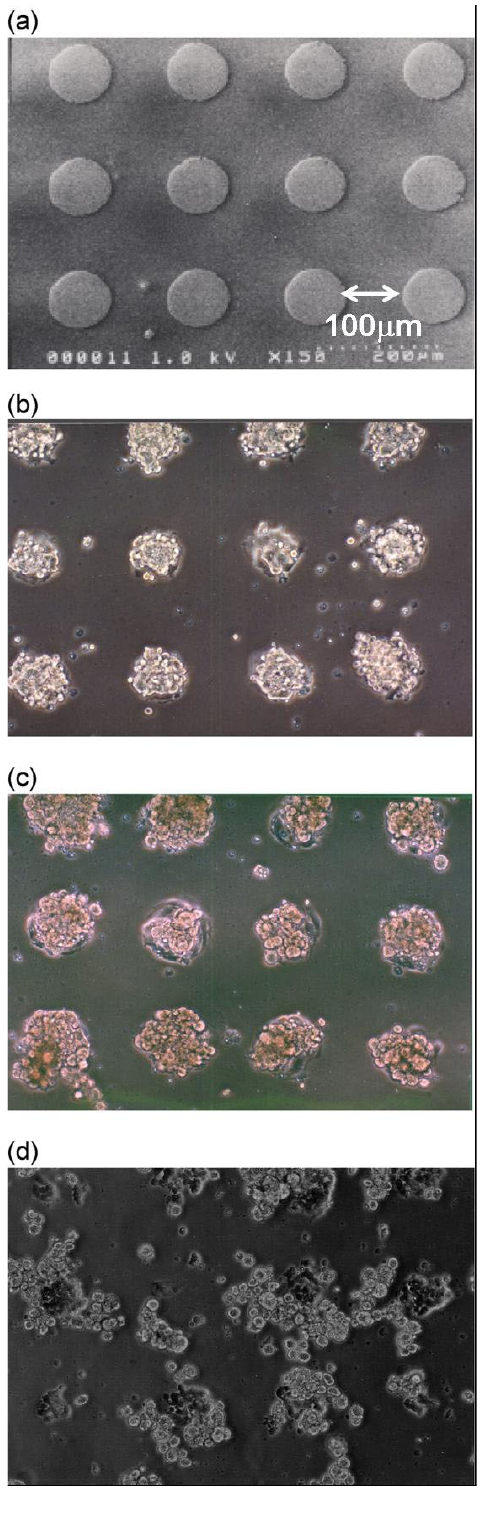
Figure 3. Patterned 3D co ‐ culture of hepatocyte spheroids and endothelial cells (BAECs). ( a ) Micro ‐ patterned α‐ lactosyl ‐ PEG/PLA ‐ coated dish with ϕ 100 μ m circular domains, spaced in 100 ‐μ m inter ‐ vals. ( b ) Patterned culture of BAECs on the substrate ( a ) for 24 h at 37 °C. ( c ) Organized pattern of hepatocyte spheroids underlaid with BAECs. ( d ) Hepatocytes directly seeded onto substrate ( a ) with ‐ out pre ‐ adhered BAECs. Adapted with permission from [30]. Copyright 2015, John Wiley and Sons.